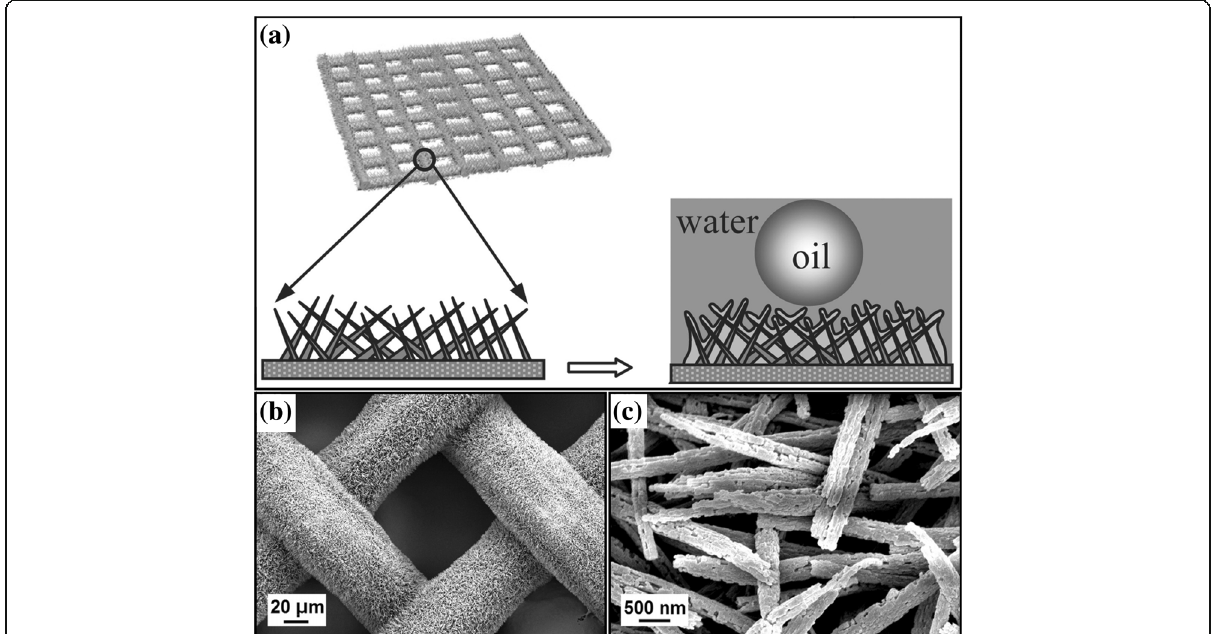
Fig. 6 a Schematic illustration of oil-wetting on a nanowire-haired membrane with a micro/nano-hierarchical structure in water. [13]. b , c SEM images of copper mesh coated with CuC2O4 nanoribbons